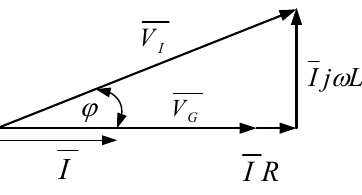
Figure 6. Single ‐ phase multilevel inverter connected to the single ‐ phase grid by a link inductor.